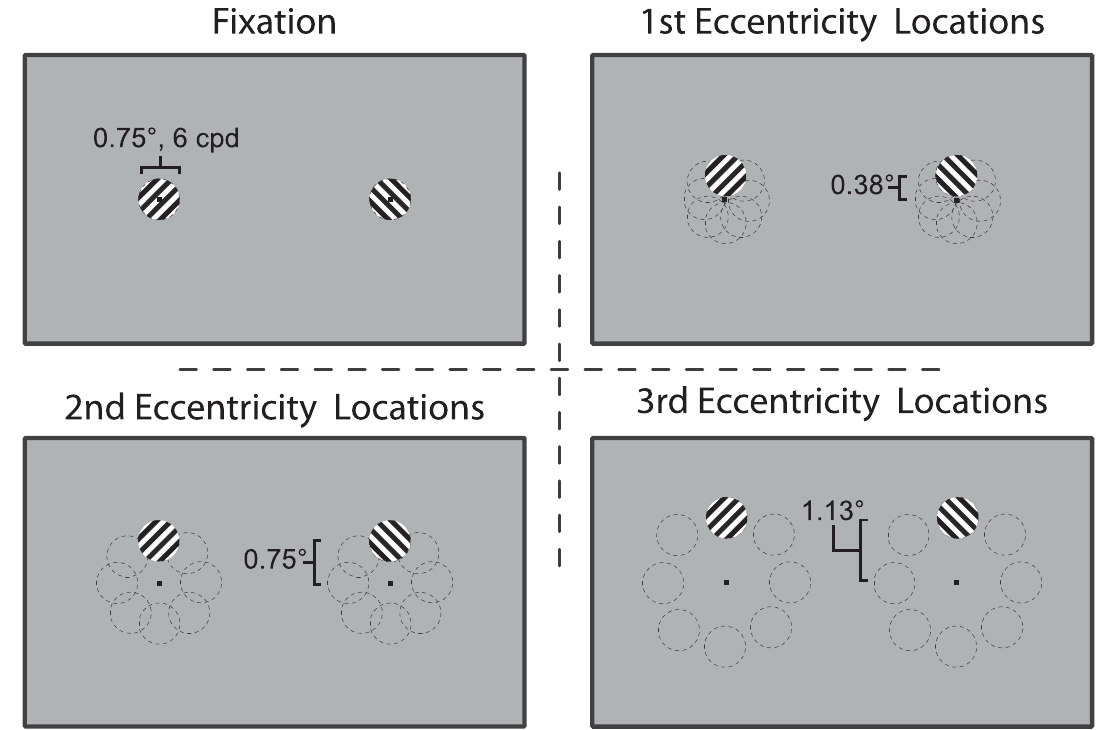
Figure 1. Stimuli Locations: The fovea was sampled in 25 overlapping locations, at fixation and at 8 locations each at 3 eccentricities. The thin dashed lines were not presented during the experiment but are shown here for clarity. To aid convergence during each presentation, the rivalry stimuli were presented within a single noise annulus (0.5 ◦ thick) framing the area of interest (not shown).